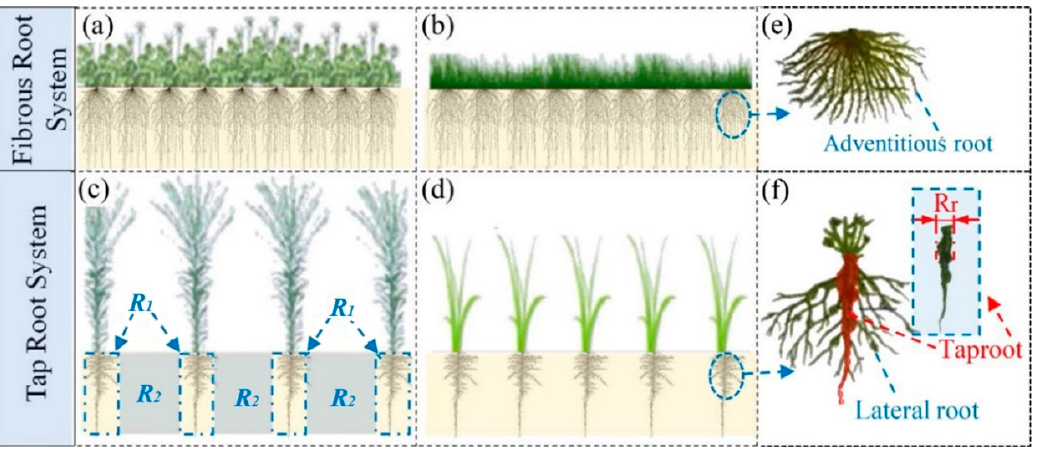
Figure 10. The schematics of the root systems of different plants: ( a ) Trefoil ; ( b ) Bermuda grass ; ( c ) Conyza Canadensis ; ( d ) Paspalum ; ( e ) schematic of fibrous root; and ( f ) schematic of taproot.